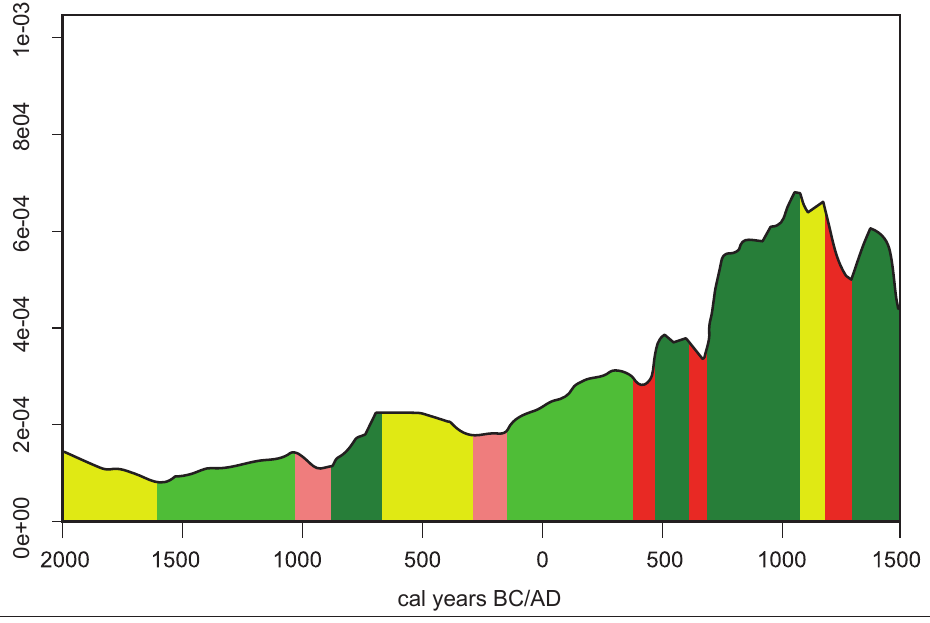
Figure 1: SCPDs for un-normalised radiocarbon dates plotted in fifty-year bins for the entire Amazon biome. Green shows moments of population growth (dark green = rapid growth); yellow shows moments of population decline; red shows population decline (dark red = sharp